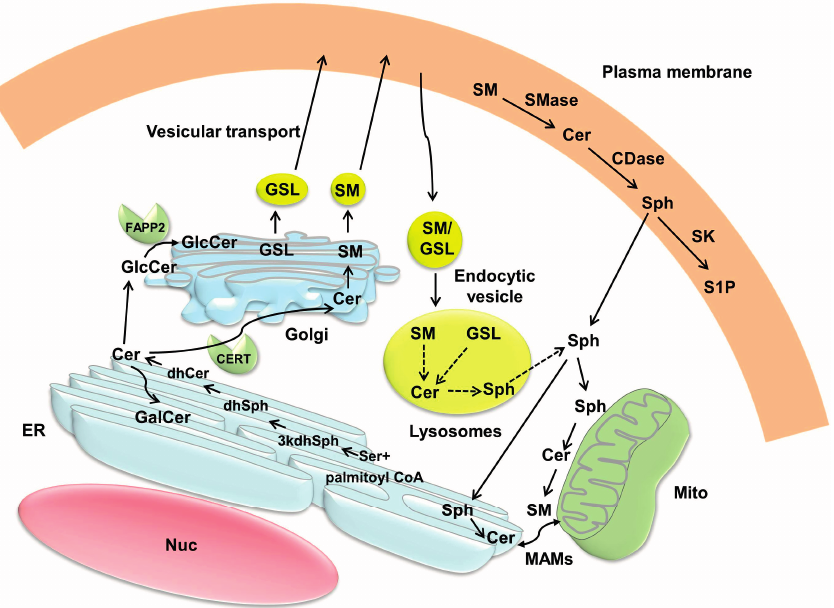
Figure 2. Compartmentalization and trafficking of ceramide. Ceramide (Cer)